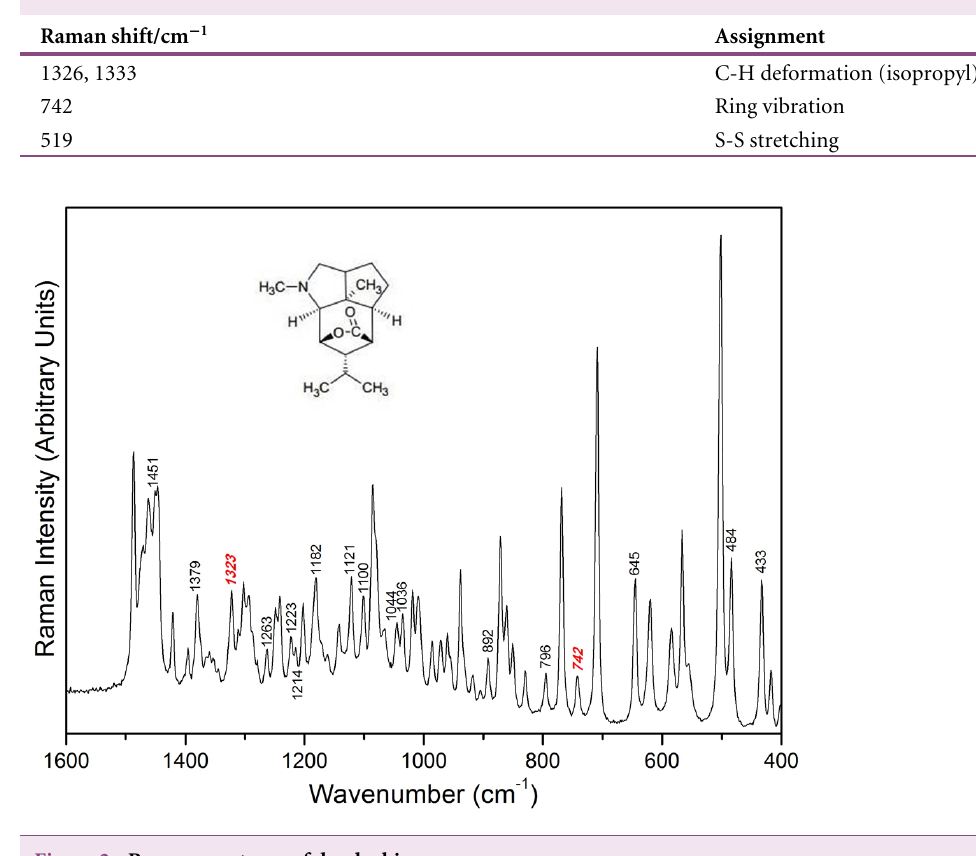
Table 2 The specific Raman shift and assignment of Dendrobium candidum/officinale.